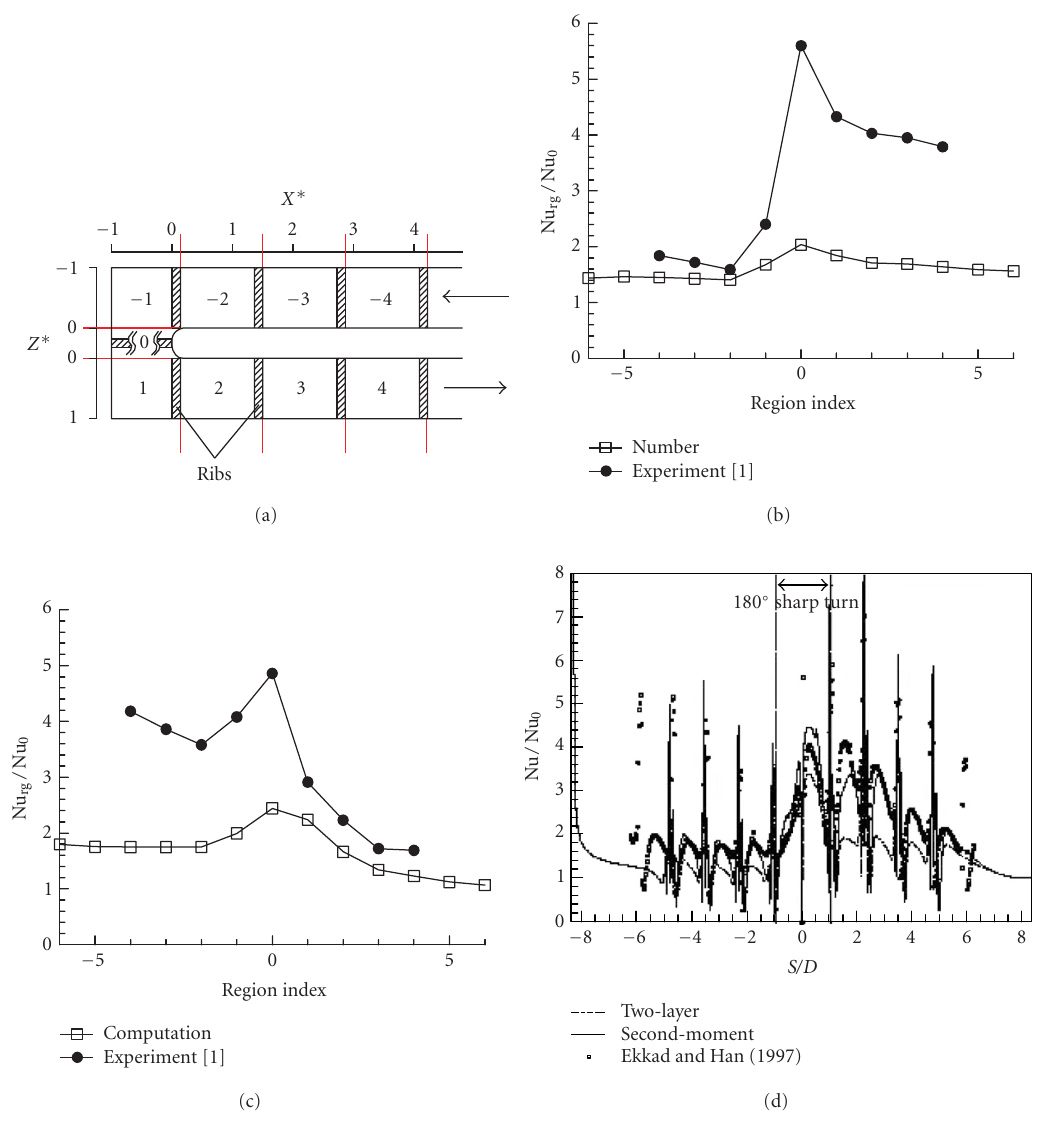
Figure 7: (a) Region index. Computed regional-averaged Nusselt number ratios compared with the measured data [1] for Ro = 0 . 15 and Re = 10000 on (b) leading and (c) trailing walls. (d) Presently computed and previously computed and measured [23] local Nusselt number